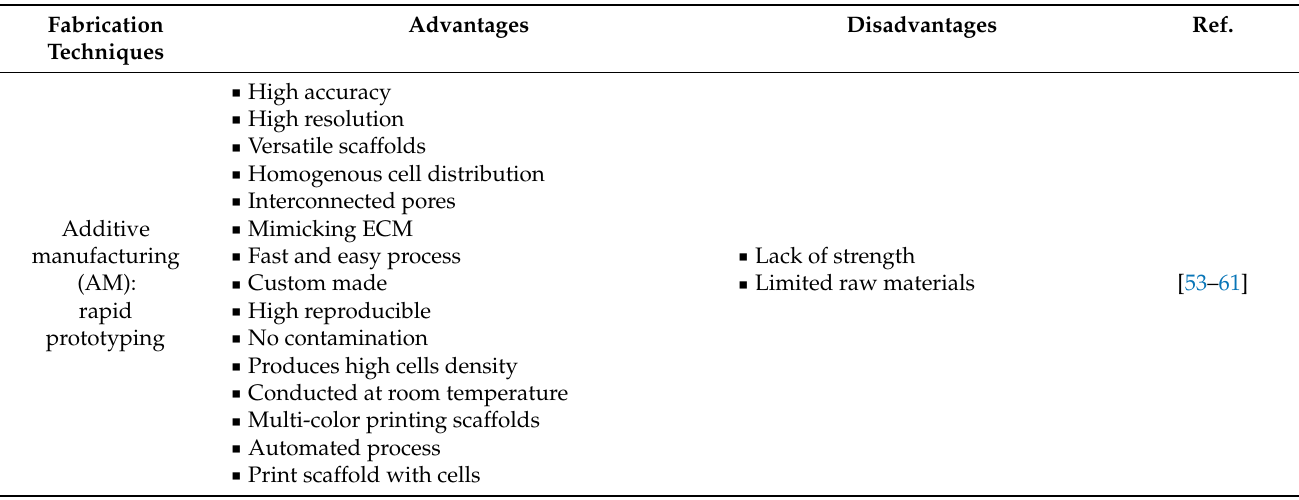
Table 1. Advantages and disadvantages of various fabrication techniques of 3D tissue engineering scaffolds.